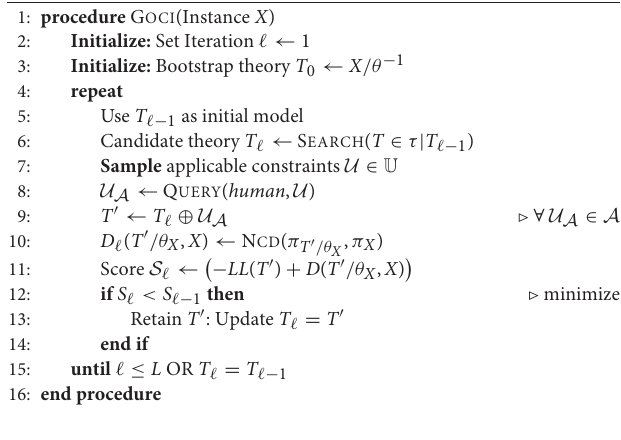
Algorithm 1: Guided one-shot concept